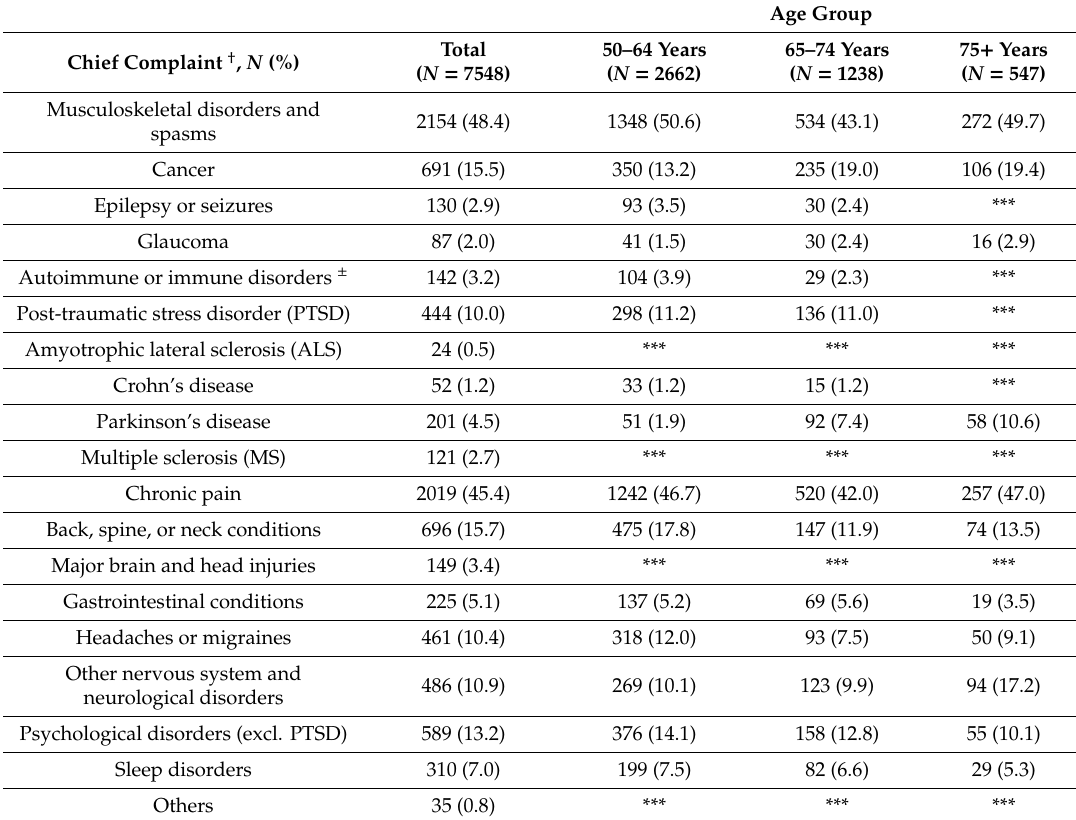
Table 2. Characteristics of Florida medical marijuana registry patients at the initial treatment visit by cannabis type